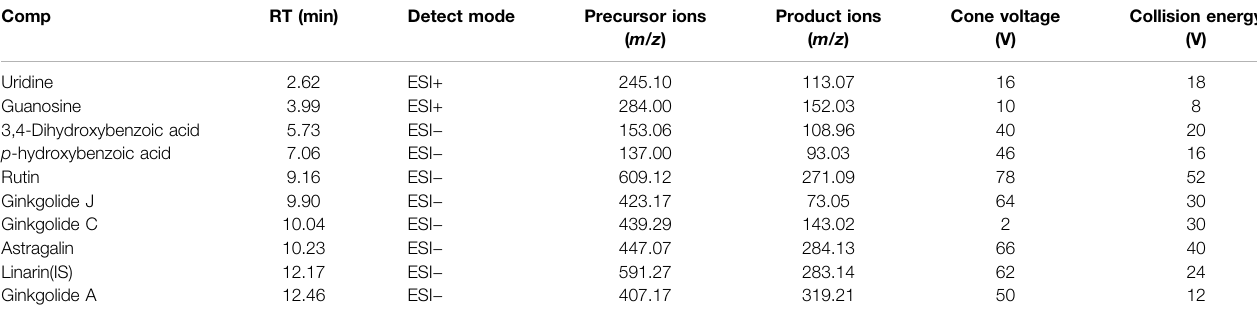
TABLE 1 | Transition and mass spectrometry parameters of nine